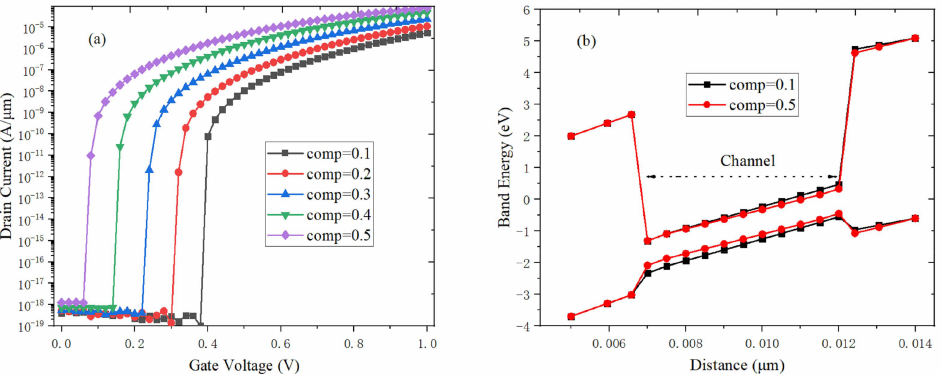
Figure 8. E ff ect of germanium content on ( a ) transfer characteristics; ( b ) on-state energy band.